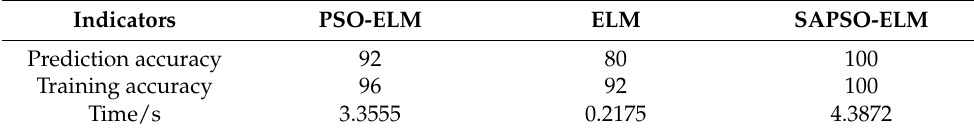
Table 5. Prediction effect of each model after KPCA dimensionality reduction.